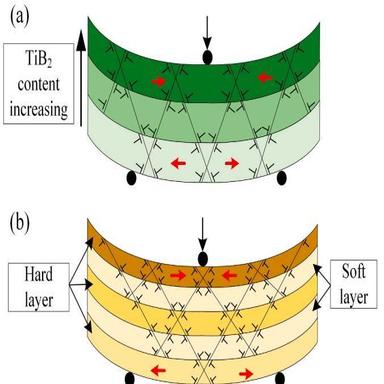
Schematic representation of deformation and fracture mechanisms of TiB2/Al7050 functionally gradient materials in bending deformation: (a) TFGM; (b) FFGM.